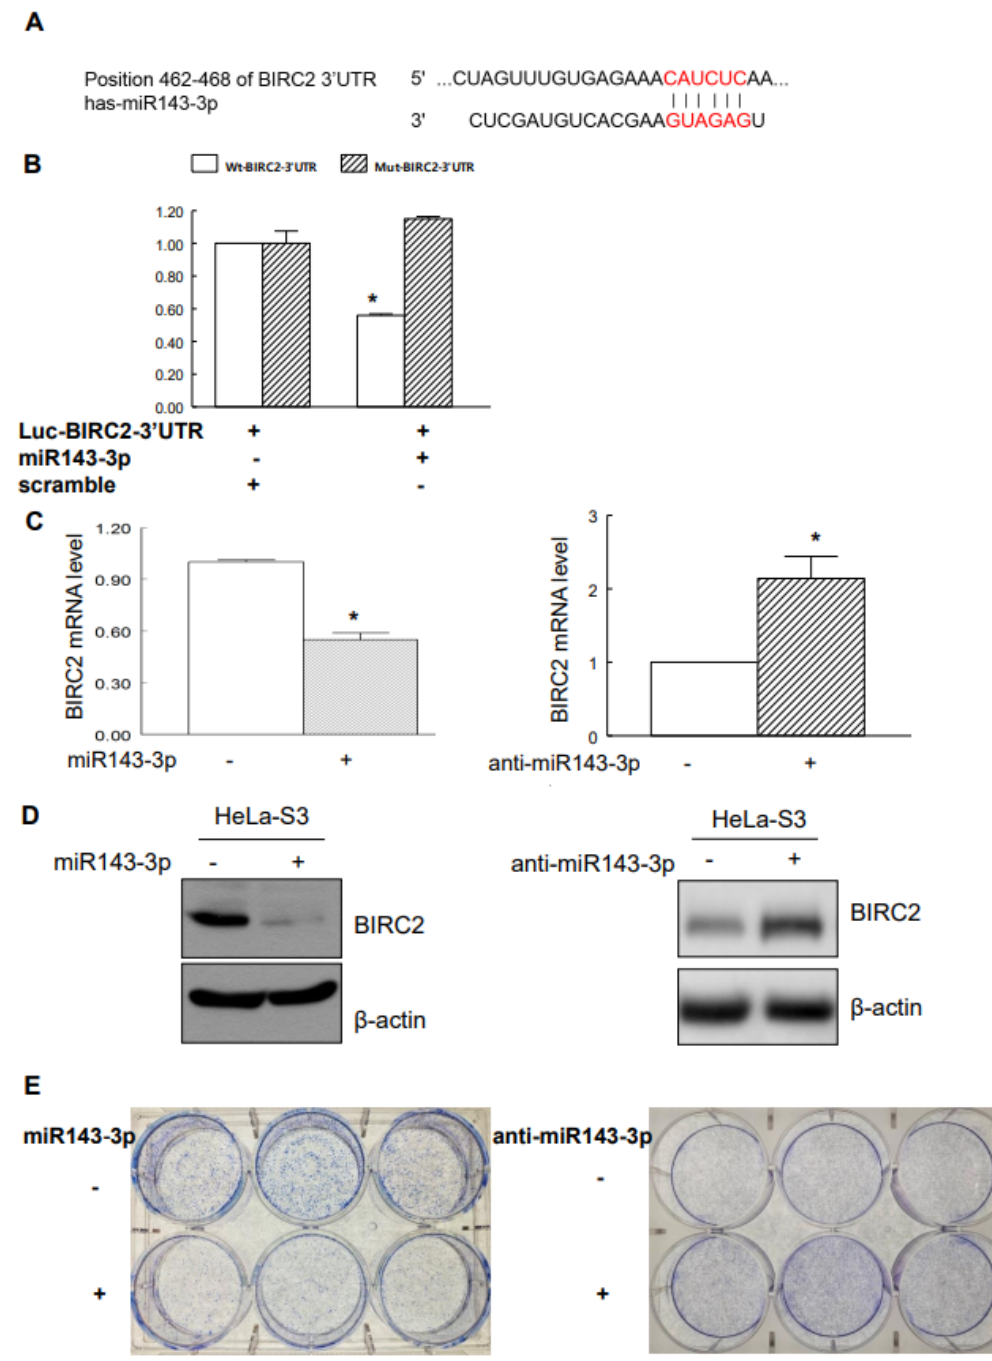
Figure 3. miR143-3p targeted BIRC2 in cervical cancer cells. ( A ) Putative target site of miR143-3p at the 3 ′ -UTR of BIRC2. ( B ) Effect of miR143-3p on the luciferase activity of wild-type Luc-BIRC2-3 ′ -UTR (Wt-Luc-BIRC2-3 ′ -UTR) and mut-Luc-BIRC2-3 ′ -UTR (Mut-Luc-BIRC2-3 ′ -UTR). HeLa-S3 cells were transfected with Luc-BIRC2-3 ′ -UTR along with miR143-3p or scrambled as a control miR for 48 h. Data are presented as the means ± standard errors of relative luciferase activity, normalized to those of scrambled controls from three independent experiments. ( C ) Suppression of BIRC2 mRNA through miR143-3p or transfection with anti-miR-143-3p increased mRNA expression of BIRC2 , as detected through real-time qPCR conducted using BIRC2 and GAPDH primers. GAPDH was used as an internal control. ( D ) miR143-3p suppressed the expression of BIRC2 protein, and the suppression of endogenous miR-143-3p with anti-miR-143-3p increased BIRC2 protein levels (as determined through immunoblotting with β -actin as a loading control). ( E ) HeLa-S3 cells were transiently transfected with miR143-3p or anti-miR-143-3p for 7–14 days. Colony formation was analyzed through the clonogenic assay. * p < 0.05 relative to